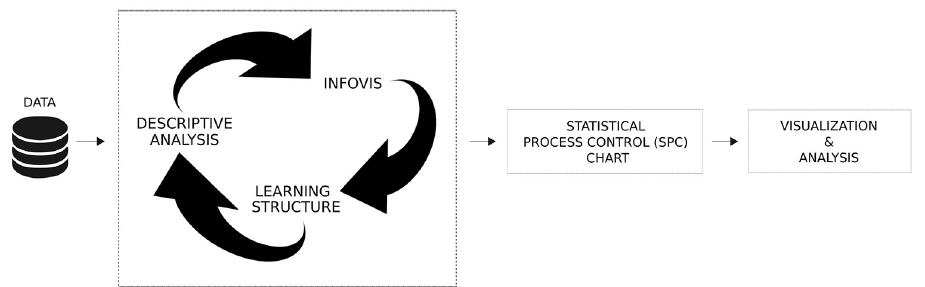
Fig 2. Visual representation of the adopted